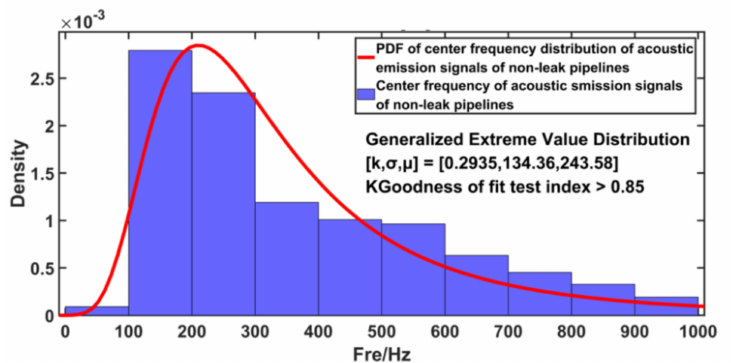
Figure 6. Distribution of the central frequencies of the acoustic signals of the water supply pipeline without a leakage.